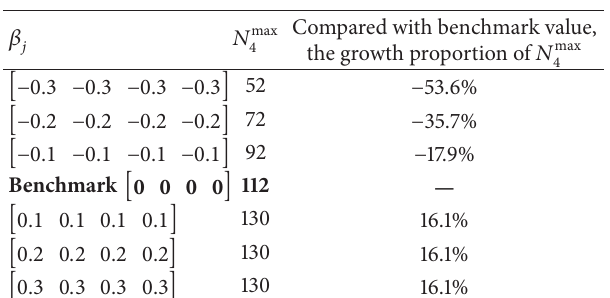
Figure 7: Curve of 𝑁 max 4 varied with 𝑅